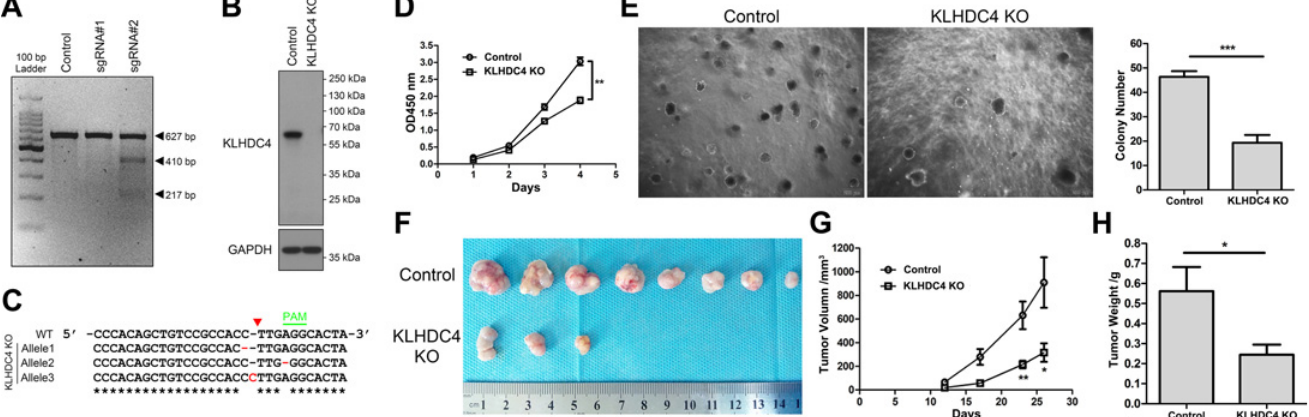
Fig 3. Knockout of KLHDC4 reduces NPC cell growth. (A) A T7E1 assay showed that mutation at the KLHDC4 locus was induced by transgenic Cas9 and sgRNA#2 but not sgRNA#1. (B) Western blotting confirmed that KLHDC4 was absent in KO cells. (C) Indel mutations induced by transgenic Cas9 and sgRNA#2 at the KLHDC4 locus. Representative DNA sequencing results for PCR products from KLHDC4 KO cells showing indel mutations at the targeted locus. Red dashes, deleted bases; Red bases, insertions; Asterisks, consensus bases; Red triangle, putative excision site. (D) KLHDC4 KO reduced the growth rate of CNE2 cells in vitro . ** P < 0.01. (E) KLHDC4 KO dramatically reduced colony formation in soft agar. Scale bars: 200 μ m. Bars denote S.E.M. *** P < 0.001. (F) All tumors isolated from mice are shown. Note none of the 8 mice inoculated with the control cells showed visible tumor growth, whereas only 3 of the 8 mice inoculated with KLHDC4 KO cells did. (G-H) Growth curves (G) and tumor weights (H) of xenograft tumors from experiments with nude mice. Changes in tumor volumes measured on the indicated days are shown. Bars denote S.E.M. * P < 0.05, ** P < 0.01.